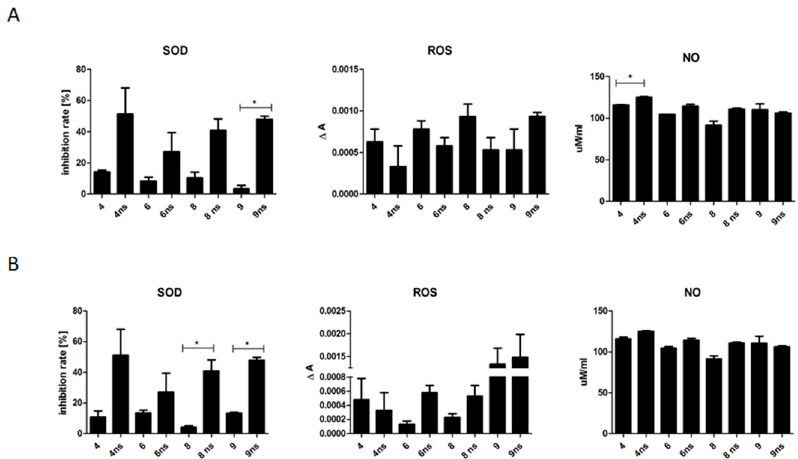
Figure 10. Levels of superoxide dismutase (SOD), reactive oxygen species (ROS) and nitric oxide (NO) in cells cultured in chondrogenic ( A ) and osteogenic ( B ) conditions and in non-stimulated control conditions (ns) in all tested biomaterials (4, 6, 8, 9, described in Table 3); * p < 0.05.